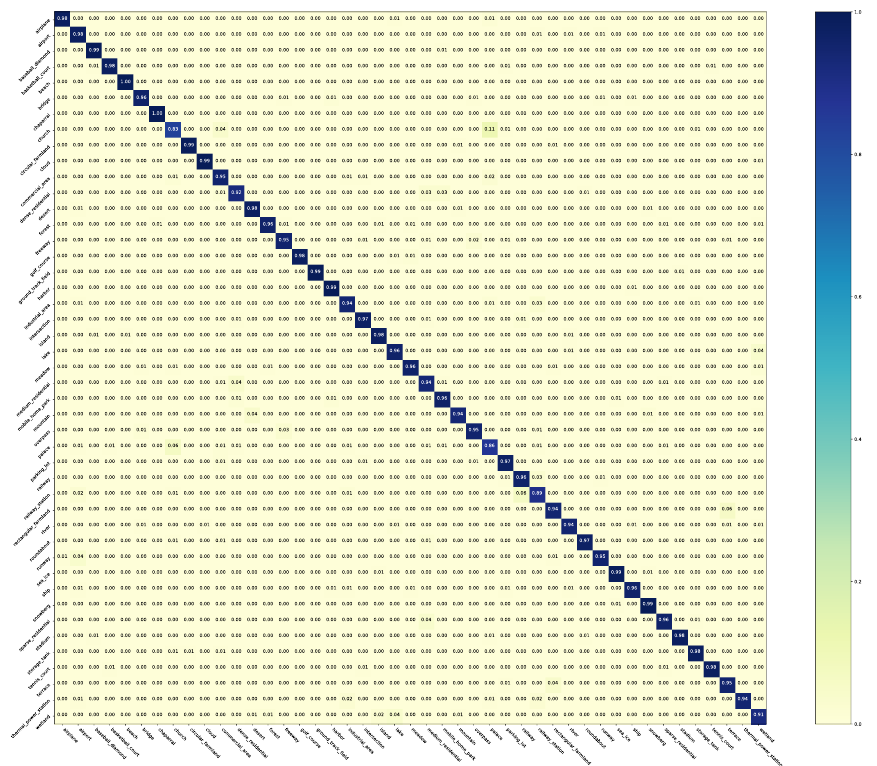
Figure 10. The confusion matrix of NLD for the